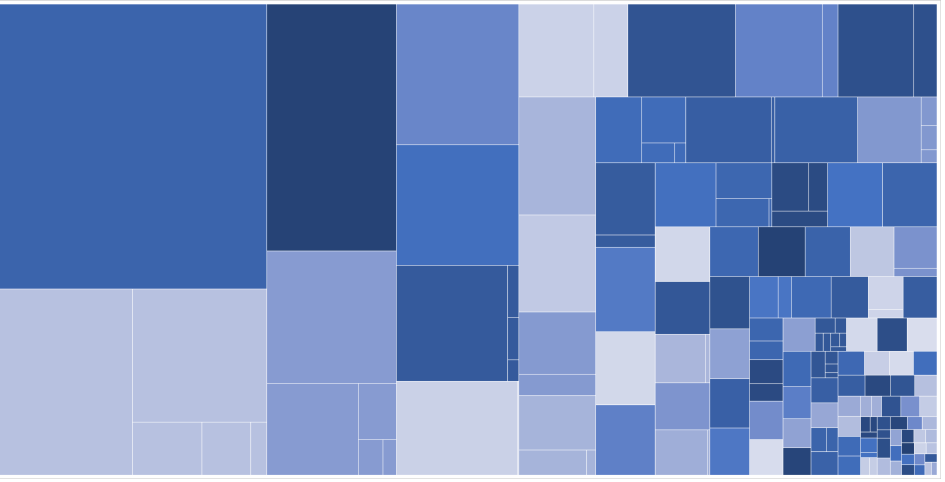
Figure 1. The estimated sizes and the structure of the label set. The area of each rectangle represents the estimated number of documents in the given label